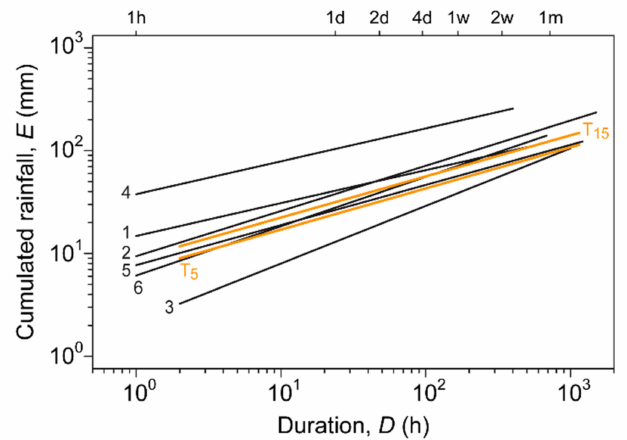
Figure 9. Comparison between the 5% and 15% thresholds for Slovenia and other global (1 and 3), regional (2 and 6) and national (4 and 5) thresholds. Source, numbered chronologically: 1, global threshold by Caine [5]; 2, threshold for Central and Southern Europe by Guzzetti et al. [6]; 3, global threshold by Guzzetti et al. [7]; 4, national threshold for Slovenia by Rosi et al. [25]; 5, national threshold for Italy by Peruccacci et al. [39]; 6, threshold for Alps by Palladino et al.